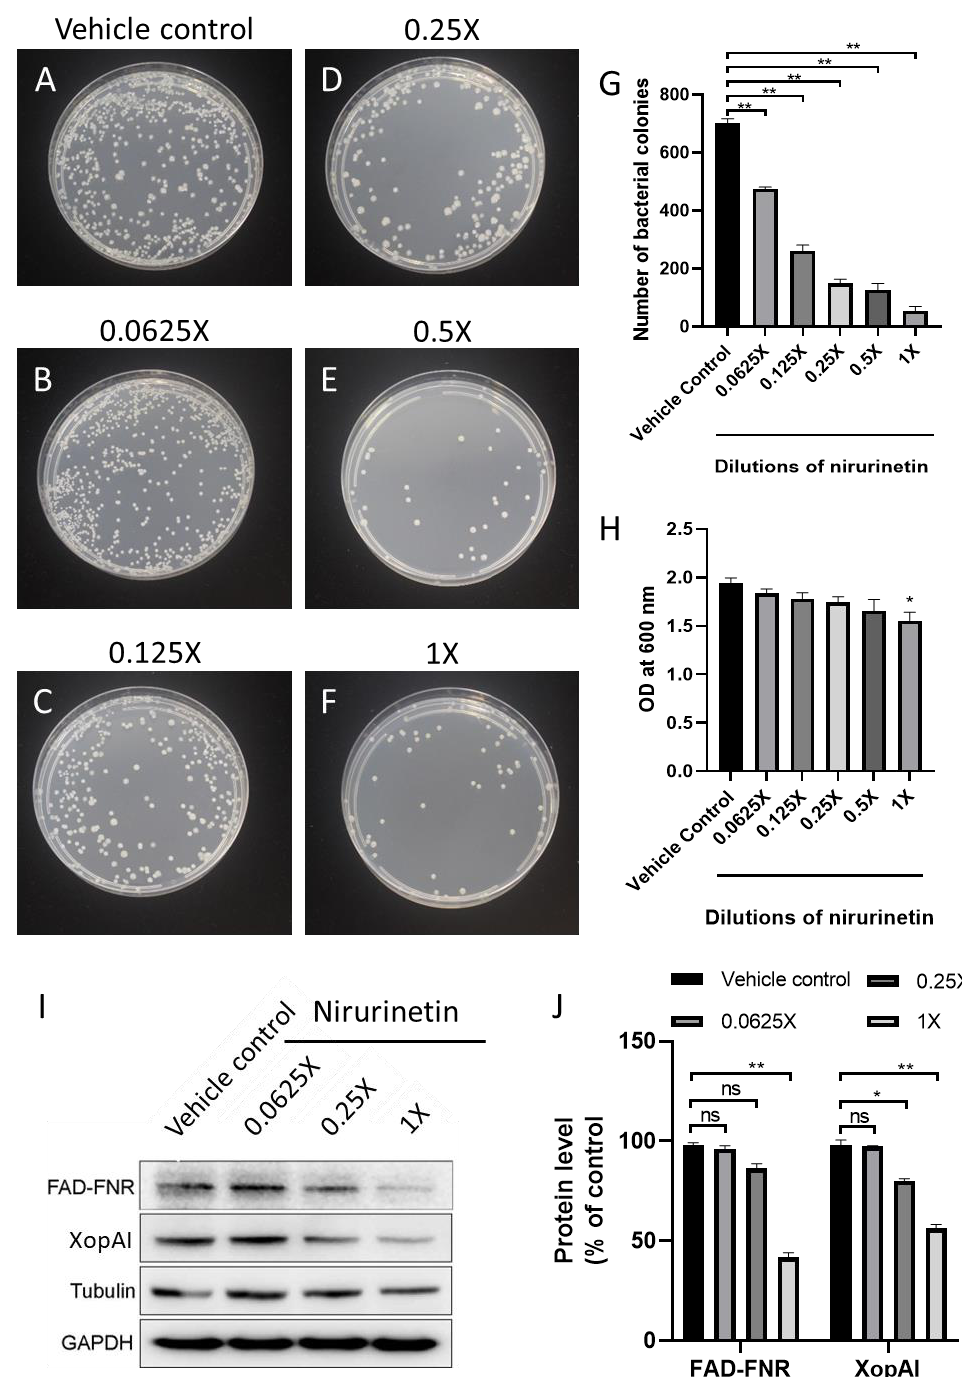
Figure 7. Effect of nirurinetin on the protein level of FAD-FNR and XopAI in X. axonopodis and its bacterial growth. ( A – H ) Representative images showing the effect of different dilutions of nirurinetin on the growth of X. axonopodis pv. and their quantitative bar graphs. ( I , J ) Representative immunoblots showing the effect of different dilutions of nirurinetin on the growth of X. axonopodis pv. and their quantitative bar graphs. Data in ( G , H , J ) are presented as the mean ± SEM (N = 3). Vehicle control vs. different concentrations of nirurinetin; * p < 0.05, ** p < 0.01, ns = not significant.